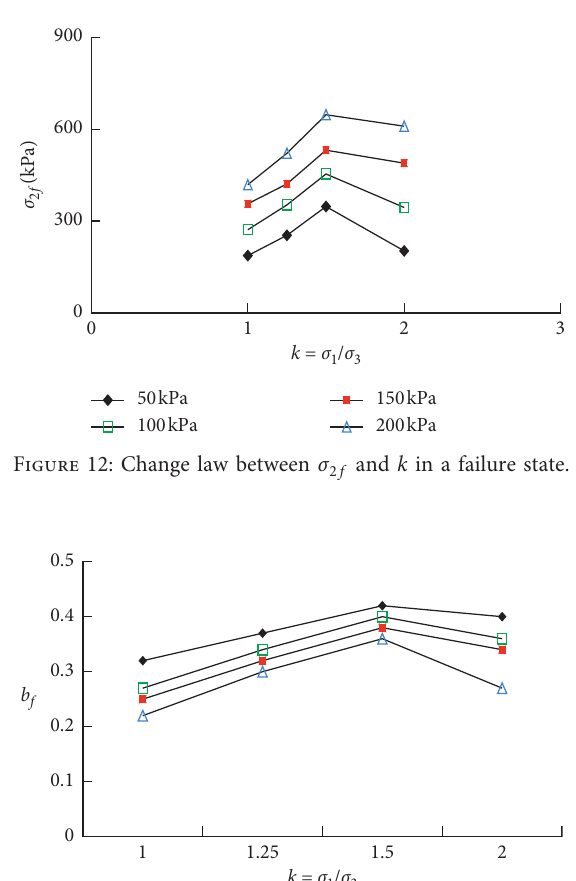
f and σ 3 in a failure state.